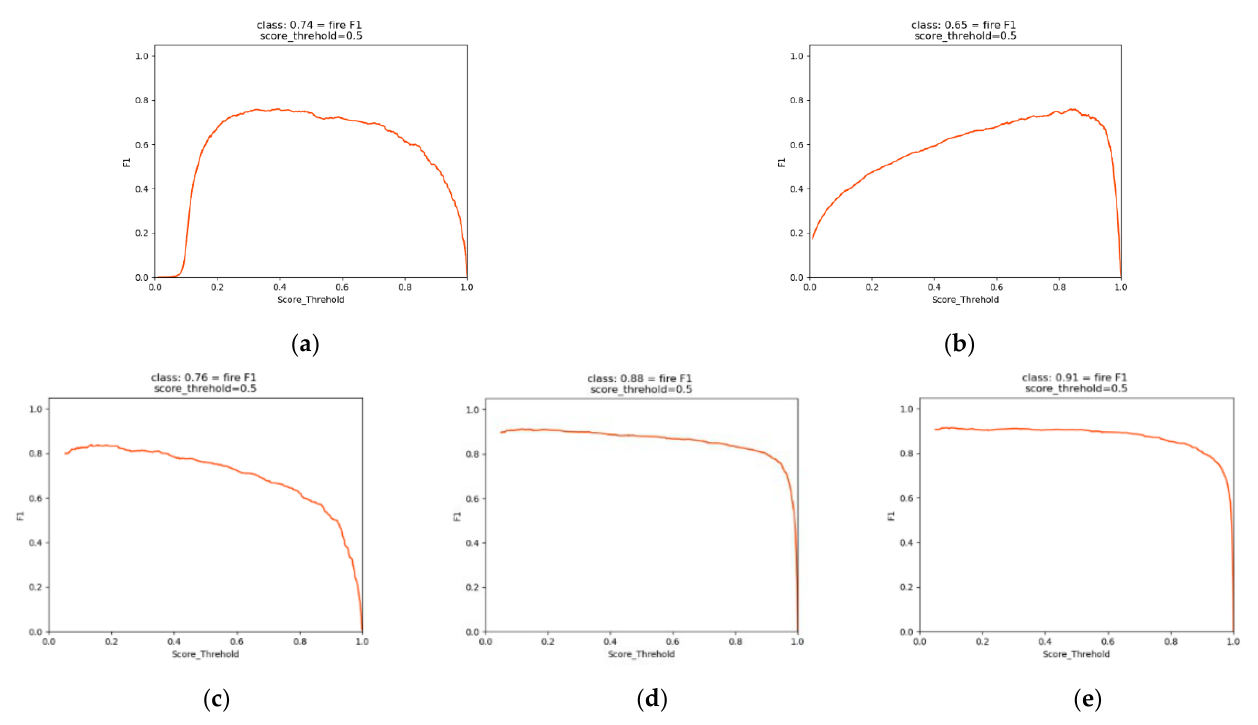
Figure 12. F 1-values of SSD, Faster R-CNN, YOLOv3, YOLOv4, YOLOv4-Kmeans. ( a ) SSD; ( b ) Faster R-CNN; ( c ) YOLOv3; ( d ) YOLOV4; ( e ) YOLOV4-Kmeans.